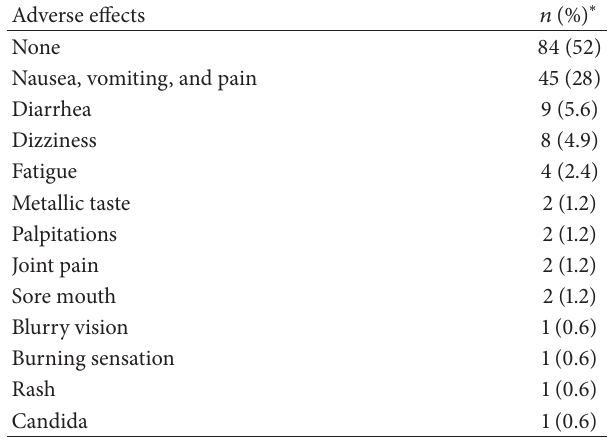
Table 2: Patient demographics. Table 3: Adverse effects with therapy.